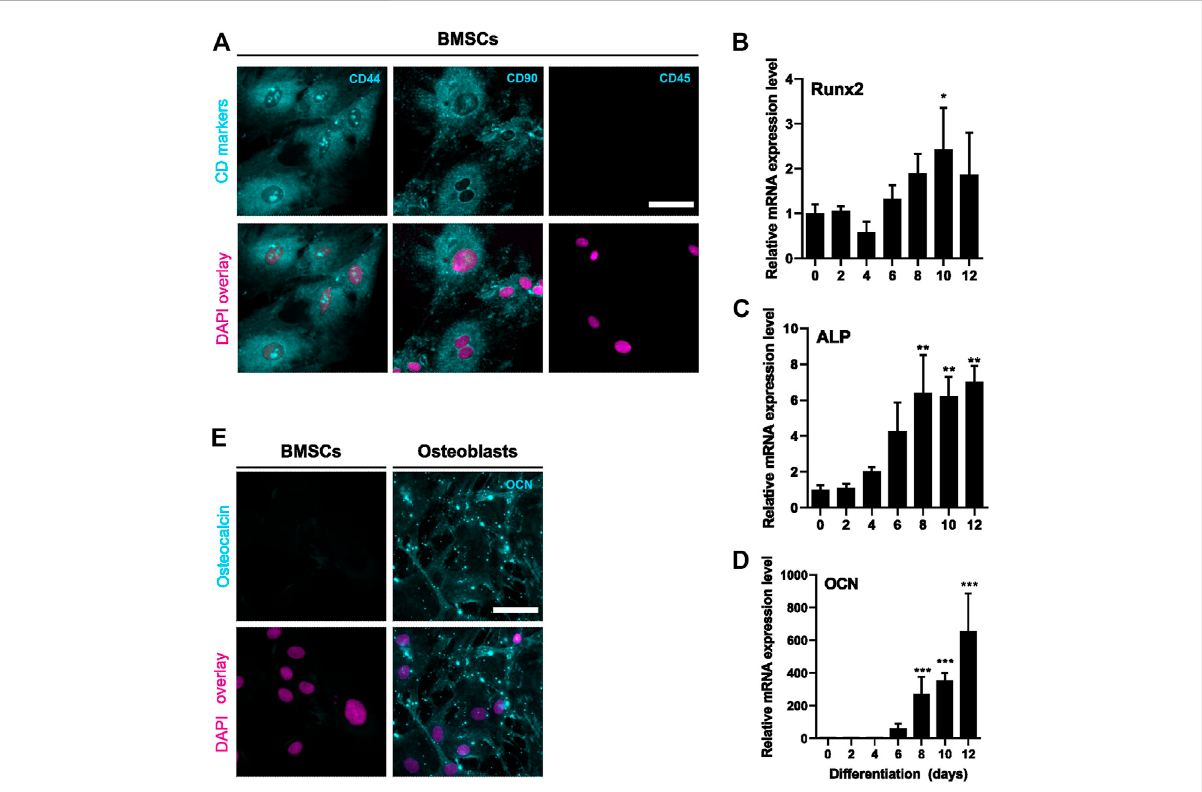
FIGURE 1 CharacterizationofBMSC andosteoblasticdifferentiation.BMSCswerestainedfor mesenchymal(CD44andCD90)andhematopoietic (CD45) cell surface markers (A) . Protein is shown with cyan and nucleus with magenta. BMSCs were differentiated to osteoblasts for 12 days and characterized for mRNA levels of Runx2 (B) , ALP (C) and OCN (D) (mean ± SD, N = 4 – 6). BMSCs were used as a control (differentiation day 0). Cyclophilin B was used to normalize the mRNA levels. Statistical signi fi cances are shown as * p < 0.05, ** p < 0.01 and *** p < 0.001 (One way ANOVA).Cultureswererepeated3timesandrepresentativeimagesareshown.BMSCsandday6osteoblastswerestainedforosteocalcin(cyan)and nuclei (magenta) (E) . Scale bar: 50 μ